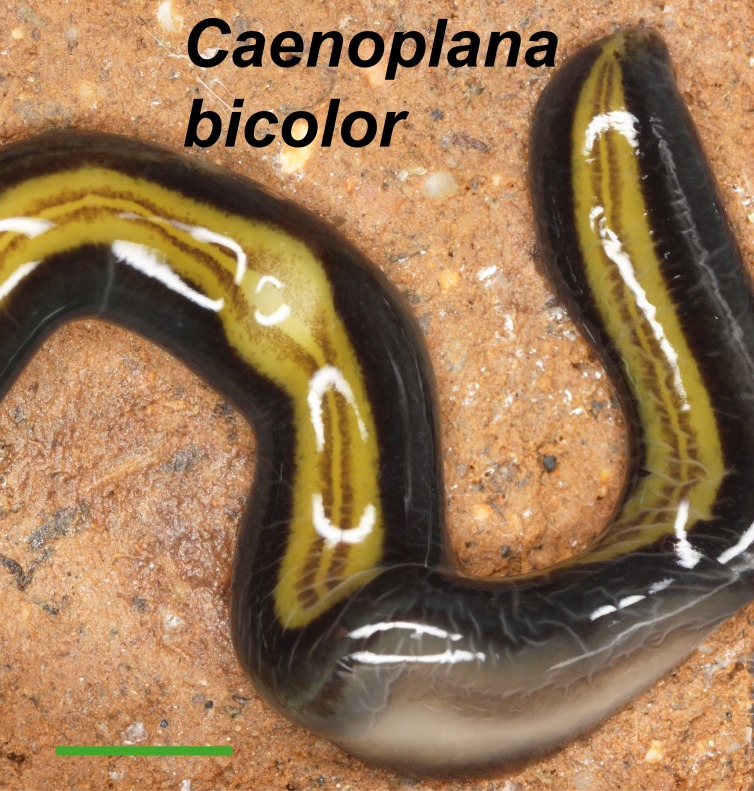
Caenoplana bicolor.Dorsal view with partial ventral view in the center. The anterior end is not shown (the specimen was damaged in this region). Scale bar 5 mm.